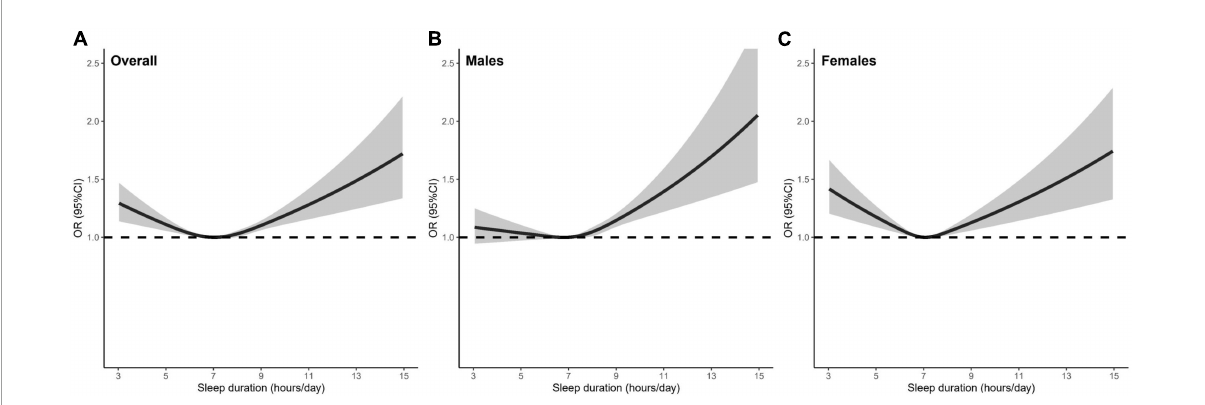
FIGURE2 The shape of the association between sleep duration and hyperuricemia in (A) overall participants, (B) males, and (C) females. The dashed line is the reference line at OR = 1. The solid curve and the shaded areas stand for the ORs and their 95% CIs, respectively. ORs were adjusted for age, sex (only for the model with overall participants), Townsend deprivation index, education level, employment status, smoking status, alcohol consumption, physical activity, fruit and vegetable intake, HDL-C, LDL-C, TG, TC: HDL-C ratio, WBC count, obesity, hypertension, diabetes mellitus. OR, odds ratio; HDL-C, high-density lipoprotein cholesterol; LDL-C, low-density lipoprotein cholesterol; TGs, triglycerides; TC, total cholesterol; WBC, white blood cell.